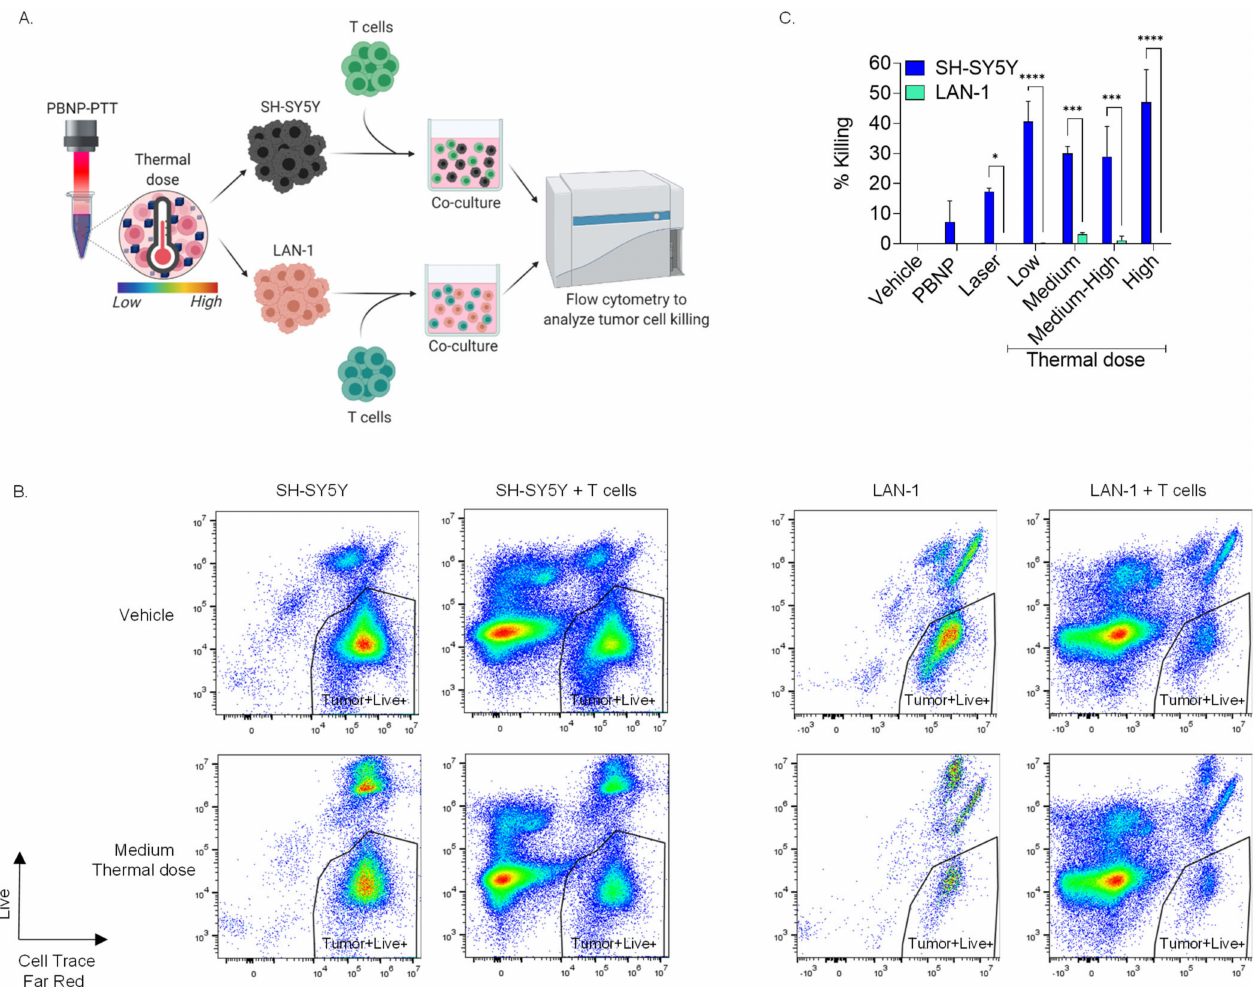
Figure 7. Equivalent thermal doses of PBNP-PTT induces greater T cell cytotoxicity against SH- SY5Y tumor cells than LAN-1 cells. Counterclockwise ( A ) Schematic representing the workflow of the co-culture study. SH-SY5Y and LAN-1 cells were treated with either control treatments or PBNP-PTT treatments at varied thermal doses (low to high). Tumor cells were then